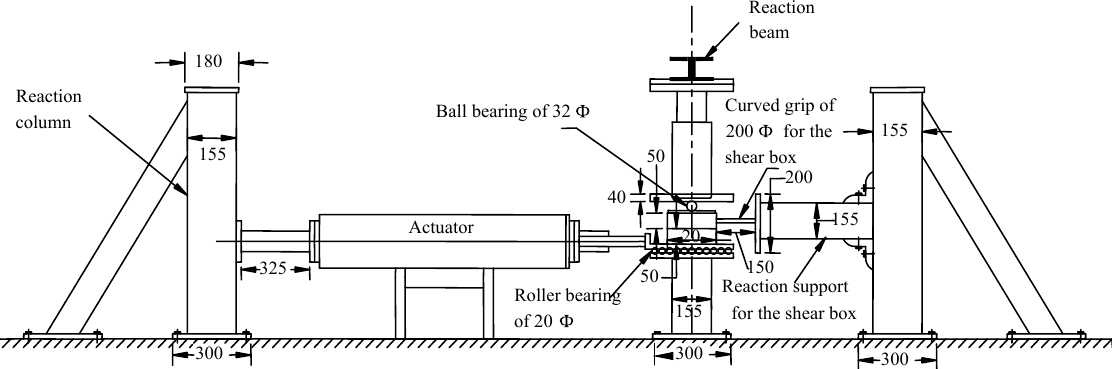
Fig. 1. Experimental set up for friction test with shear box (all dimensions are in